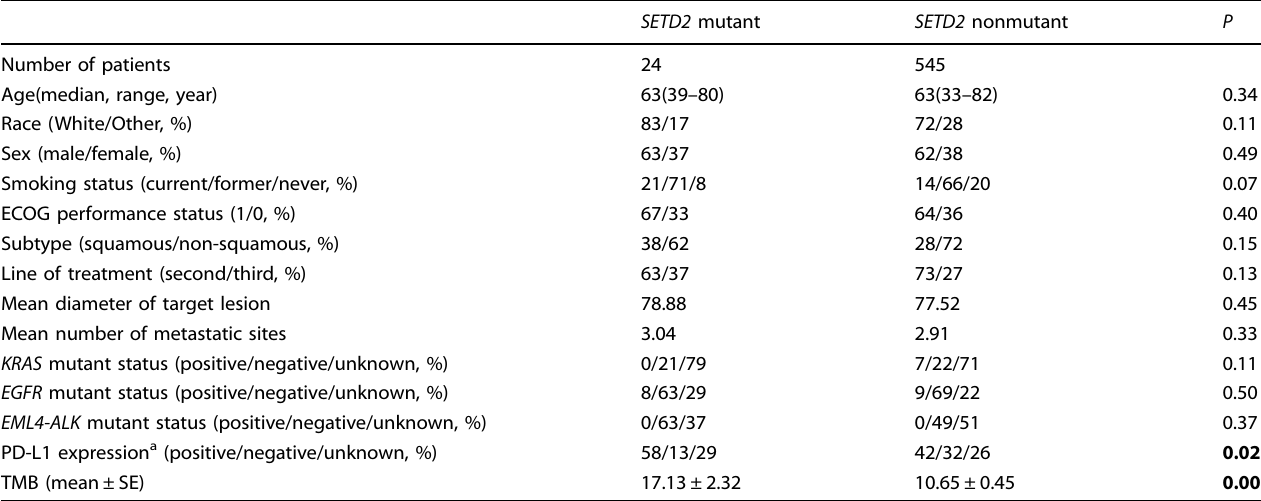
Table 2. The clinicopatholgical characteristics of patients included in POPLAR and OAK trials.